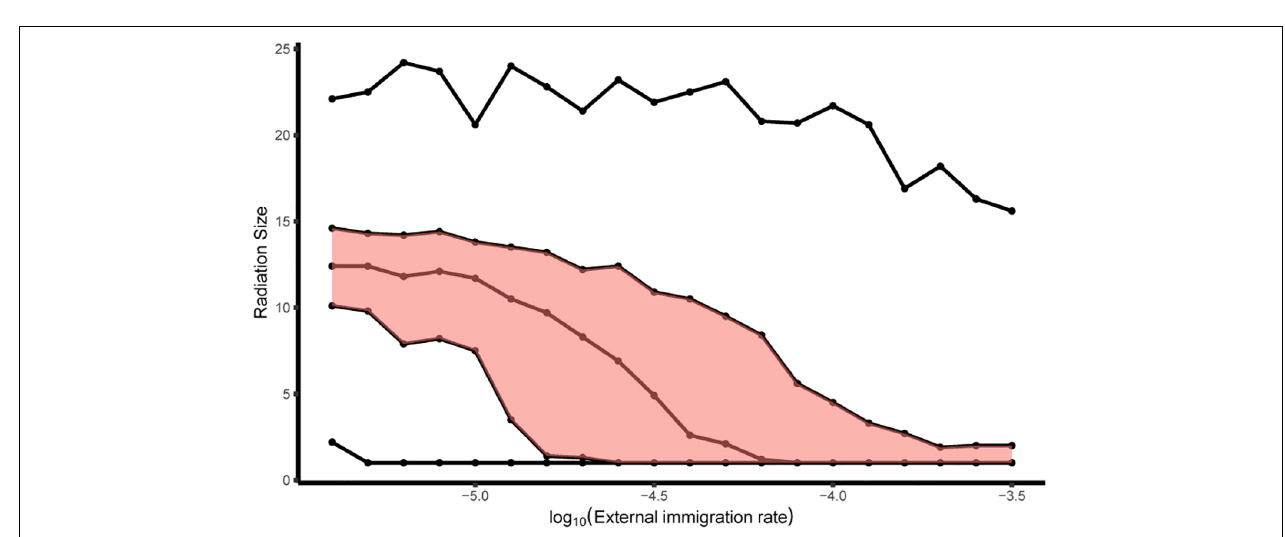
FIGURE 9 | The range of radiation sizes for all lineages in a community network as a function of the external immigration rate (M) on log 10 scale. The five lines correspond to: minimum, lower quartile, median, upper quartile, and maximum, of the distribution of radiation sizes. The range between upper quartile and lower quartile is shaded in red. The gene flow effect (G) was 0.1. Internal dispersal rate (m) was 10 - 3 . 5 and the community network was simulated with 4 patches, each having 1000